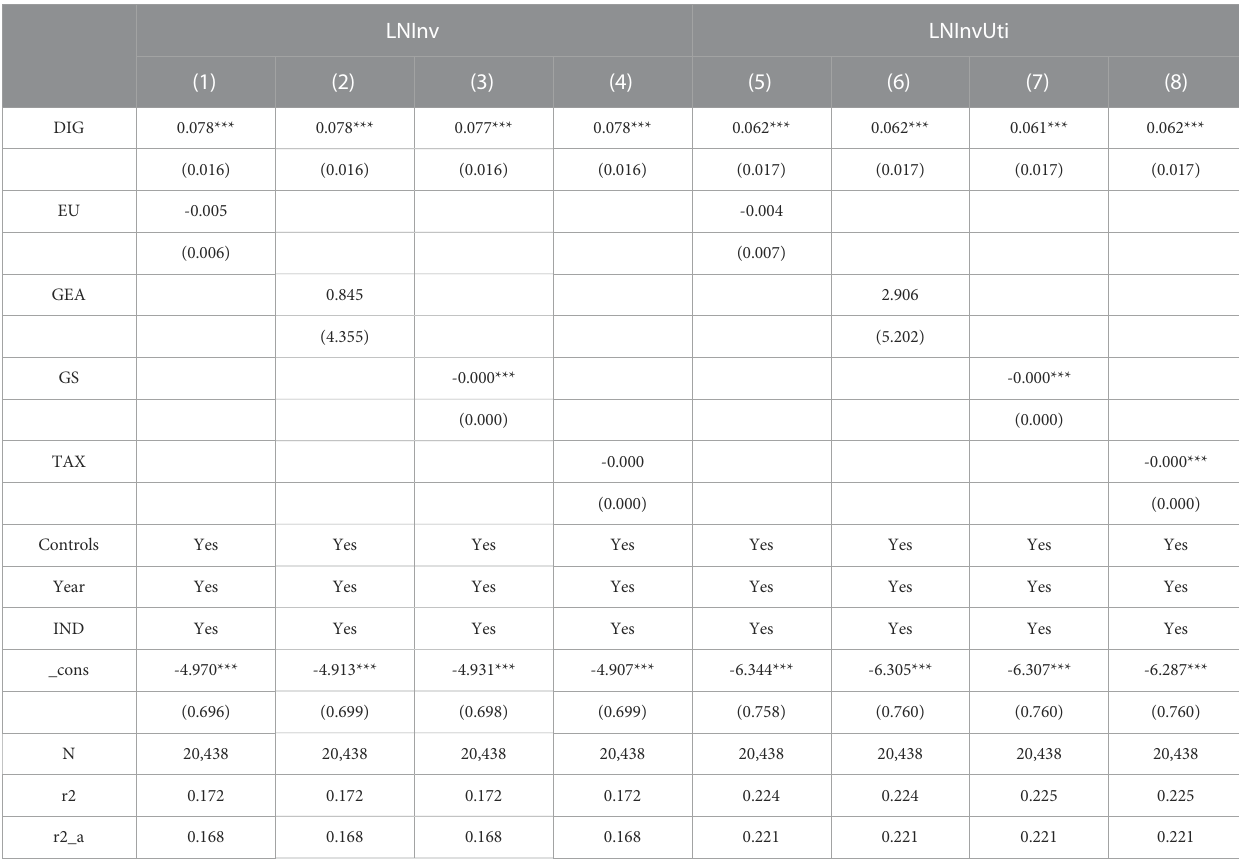
TABLE 10 Test results with added control